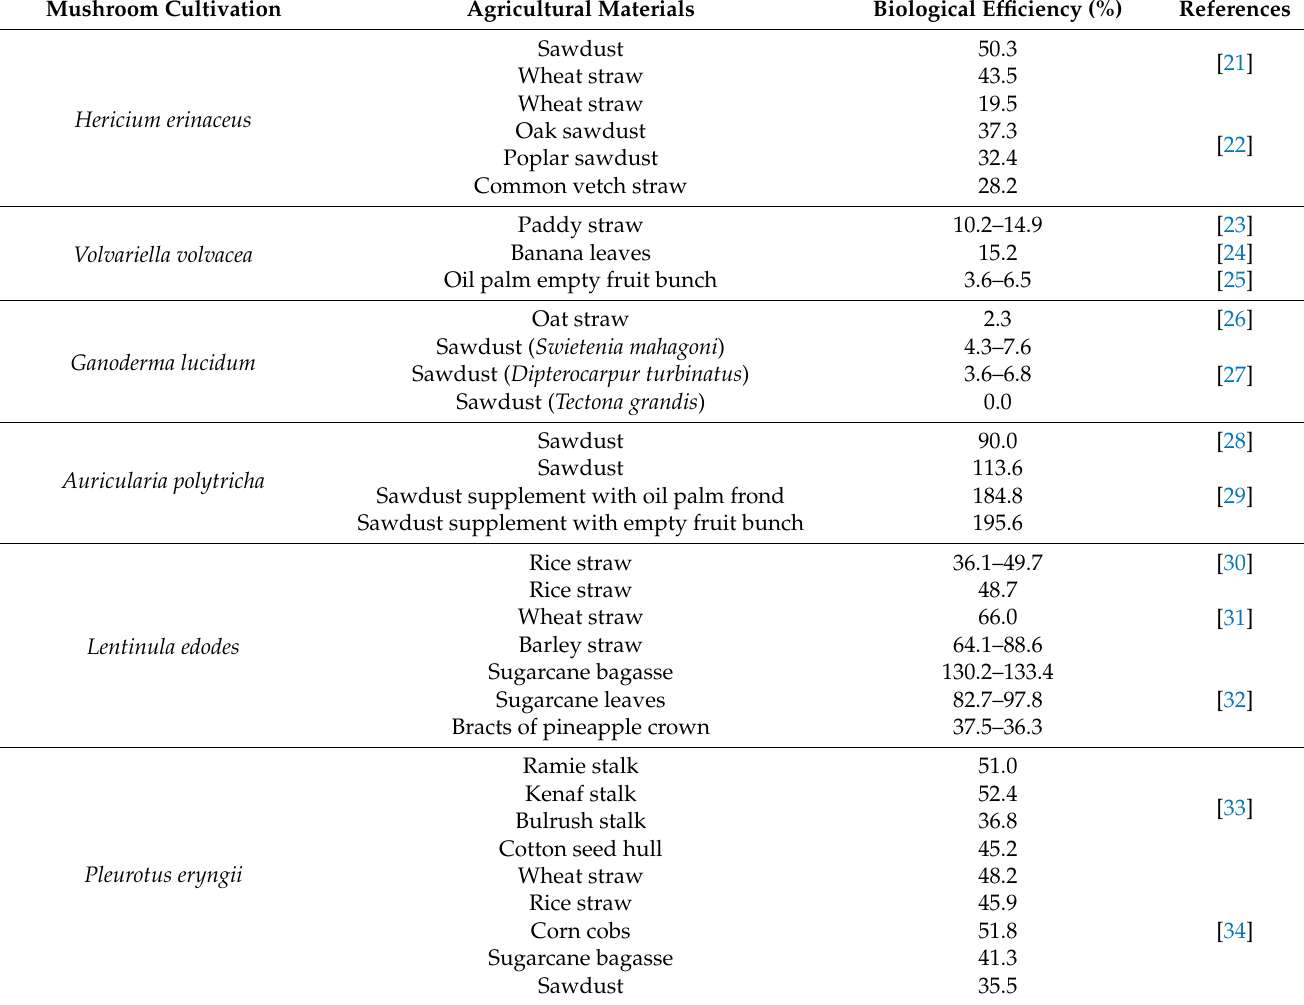
Table 1. Examples of mushroom biological efficiency obtained on various agricultural